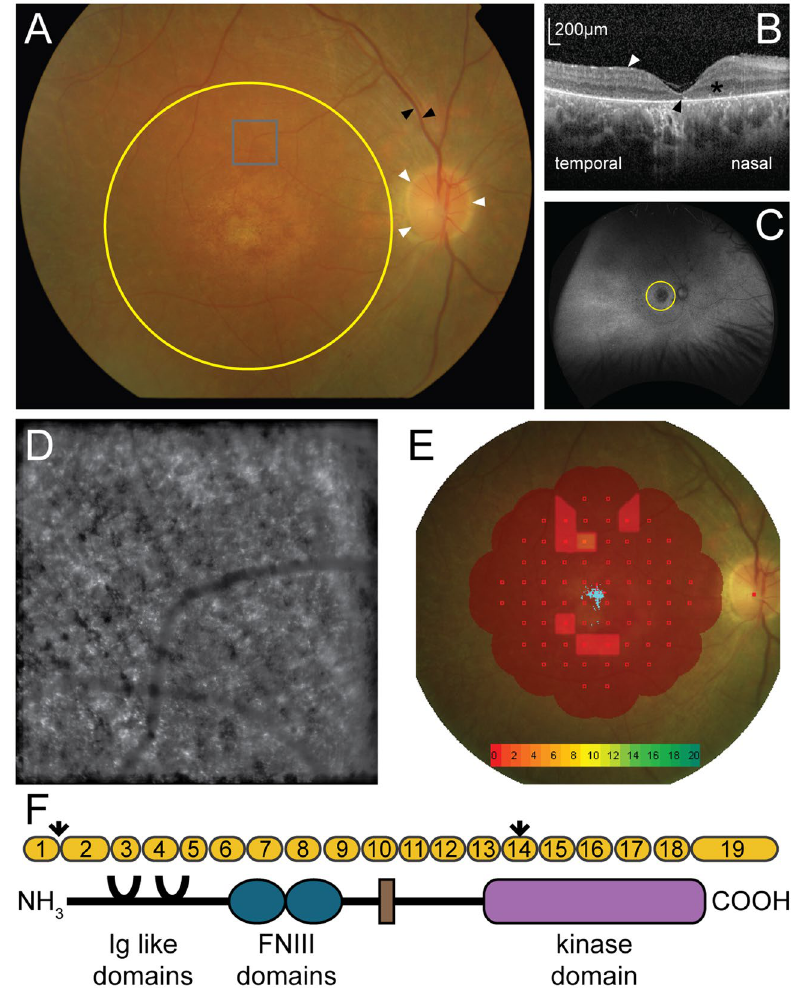
Figure 1. Phenotypic characterisation of an individual with MERTK associated retinal dystrophy. ( A) Fundus photo of the right eye showing the optic nerve (white arrows), retinal vessels (black arrows) and macula area (yellow circle). ( B) Optical coherence tomography at the right fovea showing epiretinal fibrosis (white arrow), the outernuclear layer ( * ) and expected position of the ellipsoid layer (black arrow). ( C) Widefield Optos autofluorescence image of the right retina showing the macula (yellow circle) and peripheral retina. ( D) ImagineEyes adaptive optics image of the right retina at 5 degrees superior to the fovea (grey box on panel A). ( E) Interpolated map of Nidek microperimetry of the right macula, with decibel scale (collection of blue points in centre of macula = fixation). ( F) Schematic of MERTK gene displaying the exons (yellow), the two variants (arrows), one in the first base of intron 1, predicted to interfere with splicing and a premature stop in exon 14, and the protein domains of